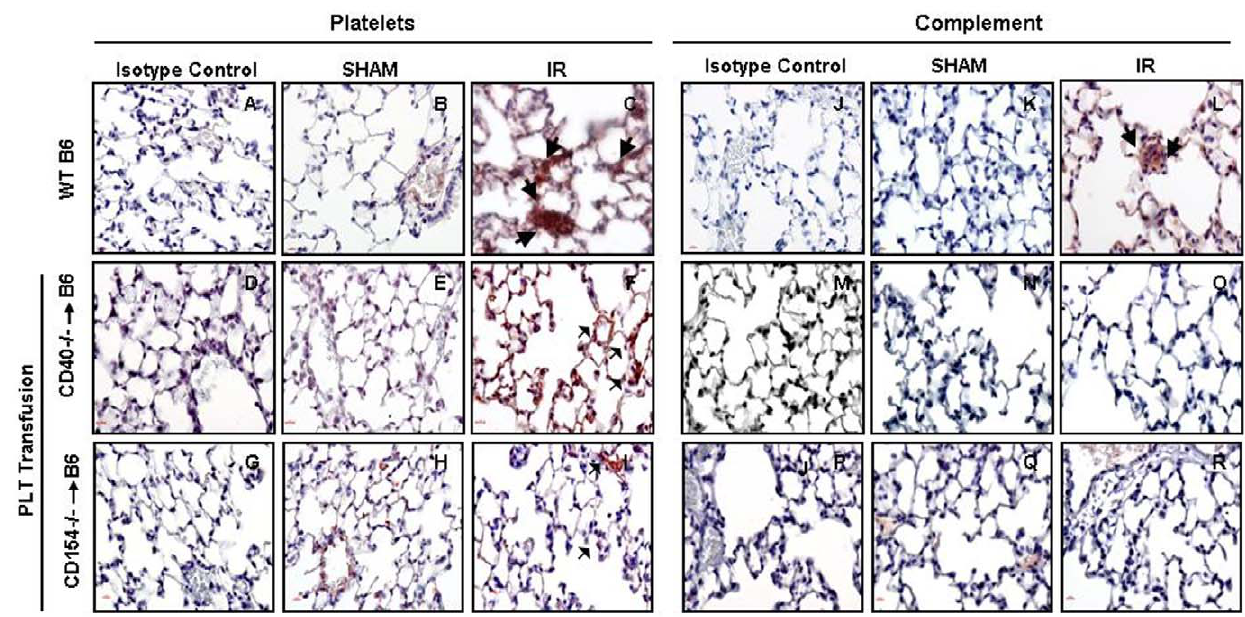
Figure 4. Reduced platelet and complement deposition in lungs after ischemia/reperfusion in CD40 2 / 2 and CD154 2 / 2 platelet transfused B6 mice. (A–R) Tissue sections of lung from B6 (top row) and platelet depleted B6 mice transfused with either CD154 2 / 2 (bottom row) or CD40 2 / 2 (middle row) platelets and mice after 30 minutes of mesenteric ischemia 3 hrs of reperfusion and sham controls were stained for platelets (A–I) or C3 complement factor (J–R) and counterstained with hematoxylin (blue). Images are representative of 3–4 mice per group. Large arrows: indicate areas with increased intensity of staining. Small arrows: indicate areas with reduced intensity of staining.